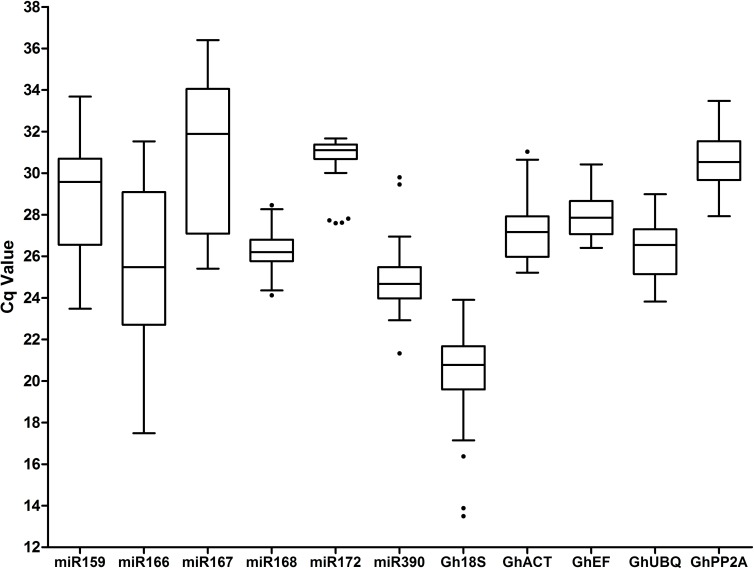
Absolute Cq values of the 11 RG candidates in all samples.Each box indicates the 25/75 percentiles. Whisker caps represent the 10/90 percentiles. The median is depicted by the line, and all outliers are indicated by dots.